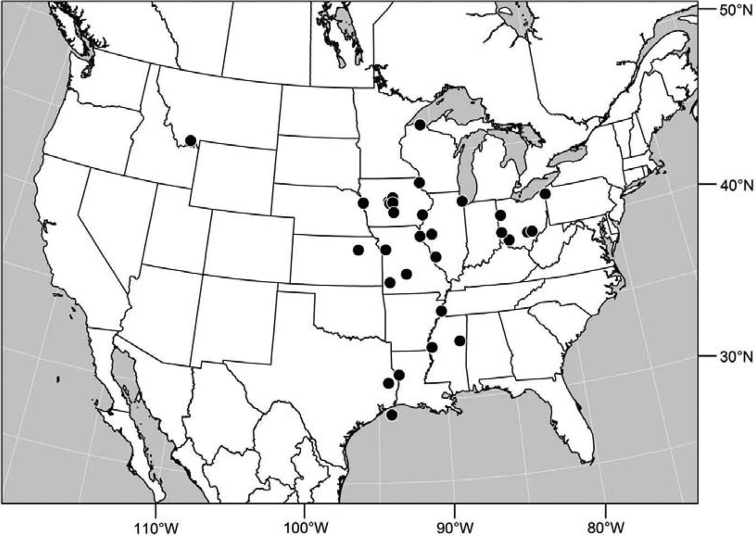
Distribution of Polytrichophora sturtevantorum sp. n.